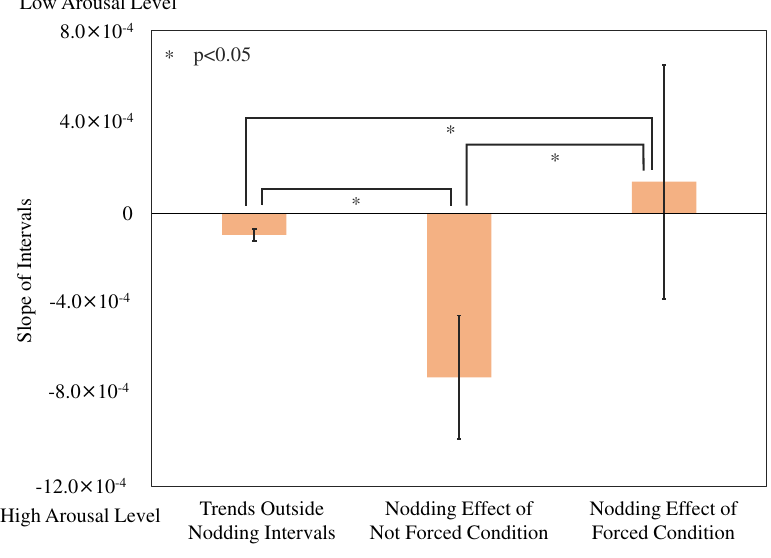
Figure 8. Results of the test of the slope of the